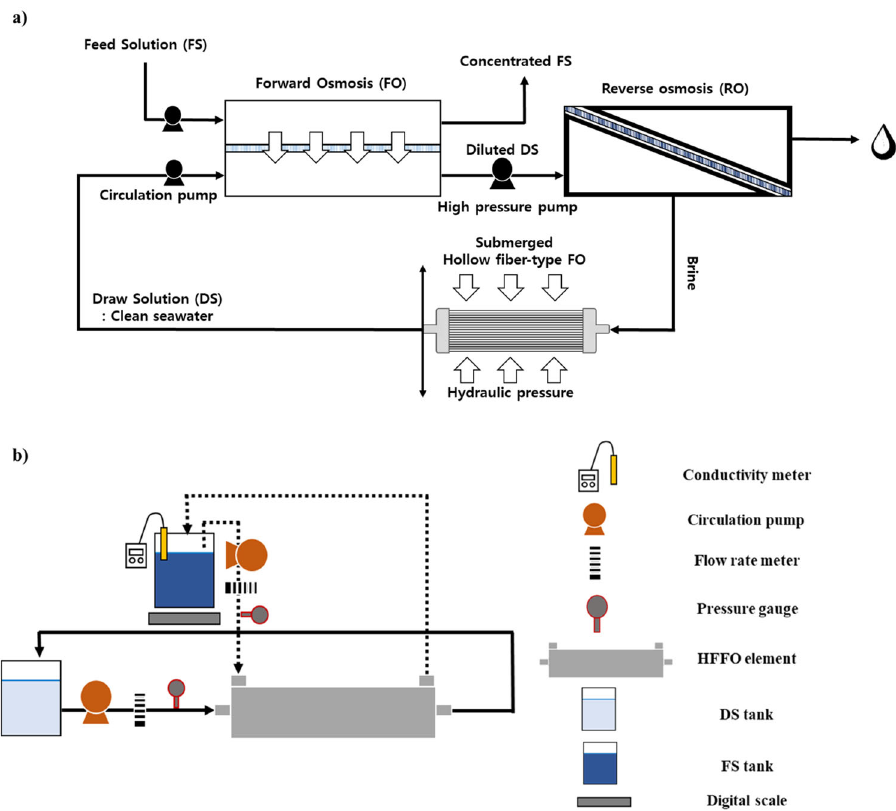
Fig. 6 Schematic of an HFFO-incorporated FO – RO hybrid desalination process (FO – RO – sHFFO) and an element-scale HFFO testing system. Panels a and b show the schematic of an HFFO-incorporated FO – RO hybrid desalination process (FO – RO – sHFFO) and an element- scale HFFO testing system (FS and DS were fed into the upper and side ports, respectively. The operation mode was counter current and the side inlet fl ow rate and pressure were continuously maintained).